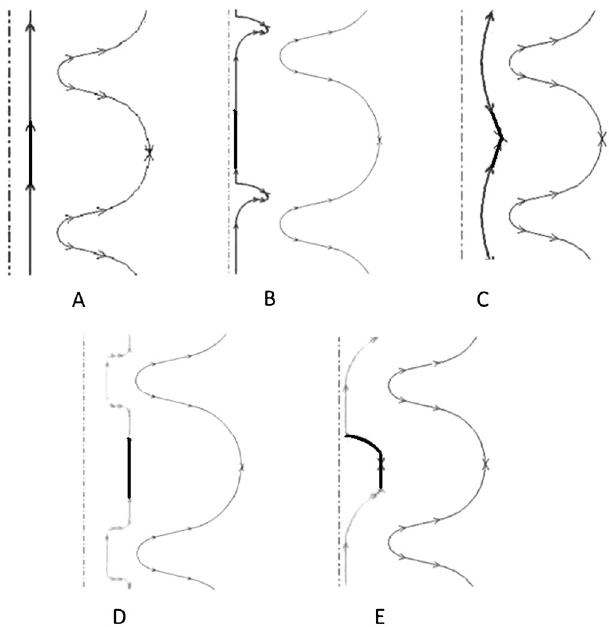
FIG. 12. Alternative insulated cathode shapes numerically tested for the Tesla cavity. At the cavity V ¼ 15 V and at the cathode V ¼ 0 . The active part of each cathode (dark color) is located in front of the